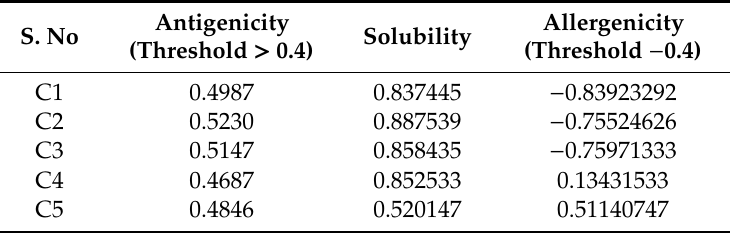
Table 3. Antigenicity, allergenicity, and solubility of the various vaccine constructs. S.